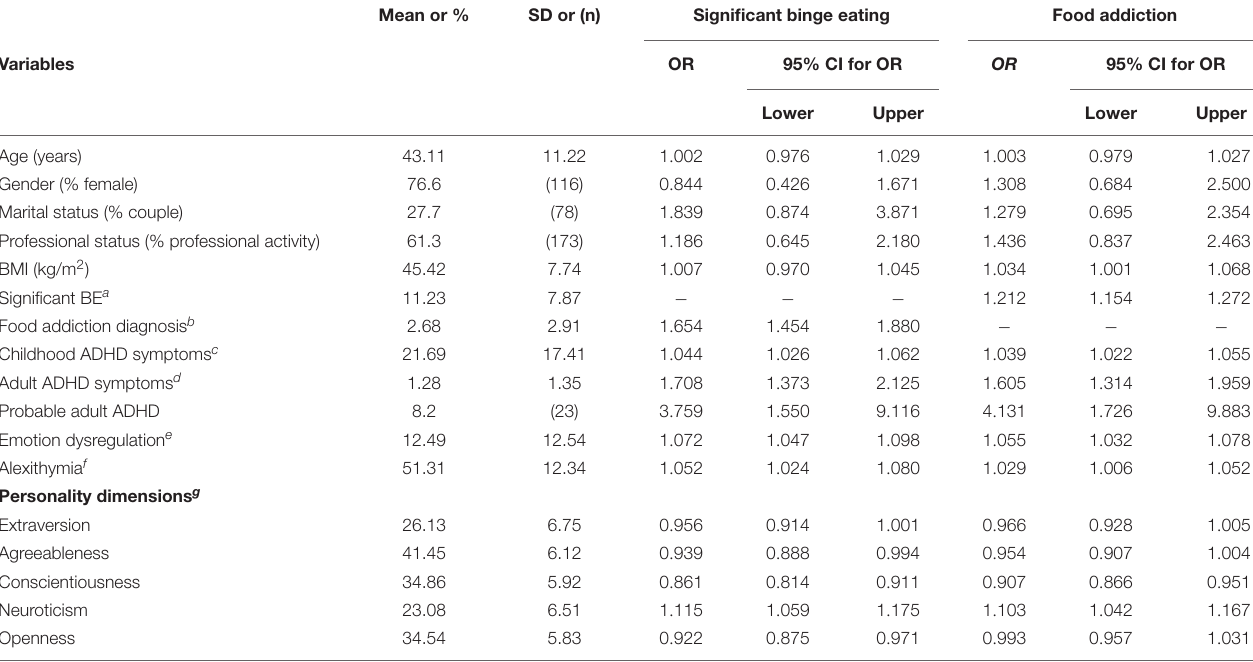
TABLE 1 | Descriptive statistics of the whole sample and logistic regression depending on FA and significant BE